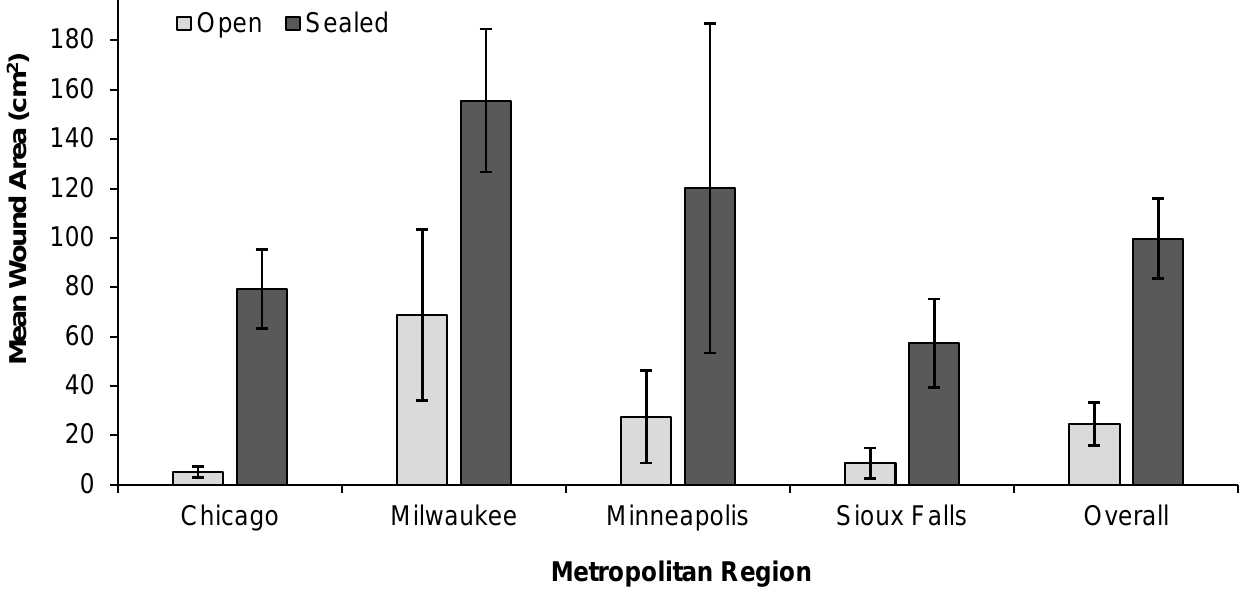
Figure 1. Mean total wound area by treatment and metropolitan region for open (plug-less) and sealed (plug) systems for emerald ash borer ( Agrilus planipennis Fairmaire) treatment in green ash ( Fraxinus pennsylvanica Marshall) trees. (Bars are SE, F(1, 363) = 17.406, p < 0.001).